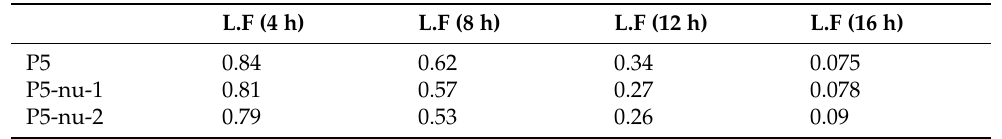
Figure 10. Contours of the PCM liquid-fraction progression for three different HTF-tube arrangements of P5, p5-nu-1, and p5-nu-2 over multiple solidification durations. Table 6. The PCM liquid-fraction progression for three different HTF-tube arrangements of P5, p5-nu-1, and p5-nu-2 over multiple solidification durations.